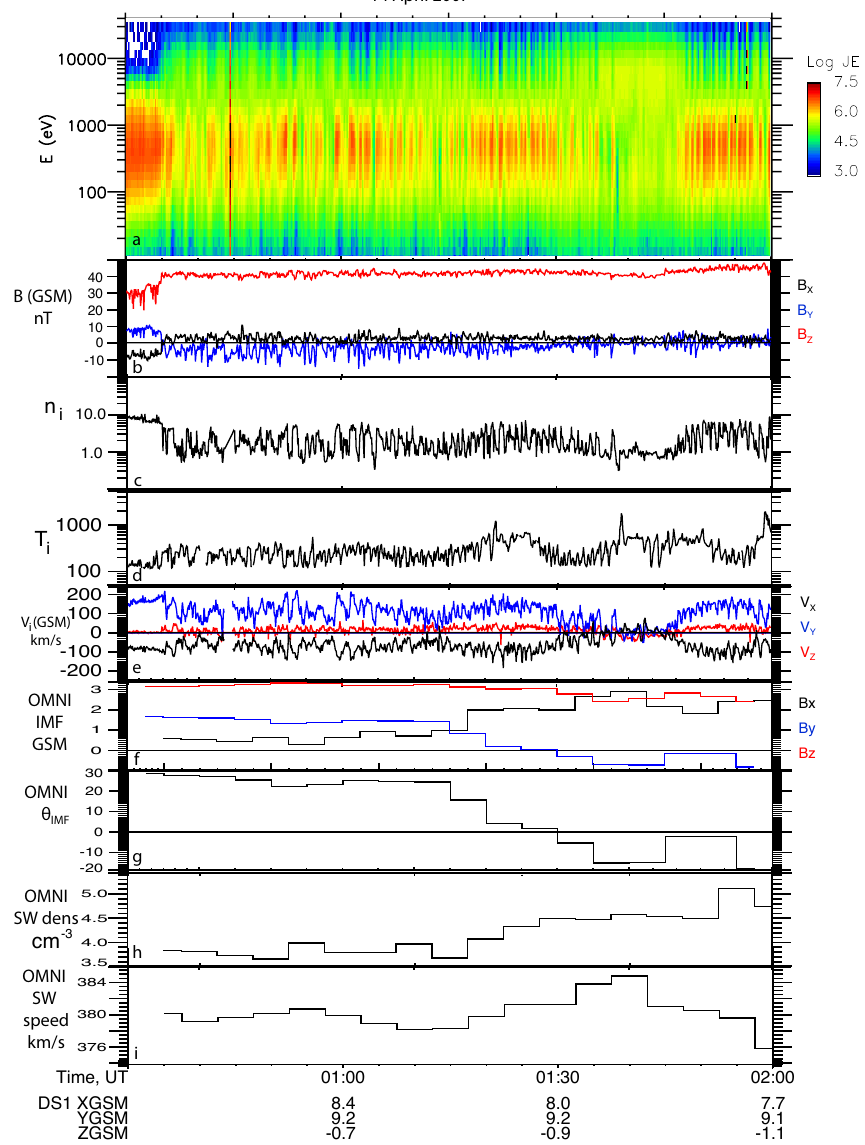
Fig. 1. An example magnetopause crossing on 14 April 2007. Panel (a) shows an omnidirectional ion differential energy flux spectrogram, panel (b) the magnetic field GSM components, panels (c) – (e) show the ion density, temperature (parallel and perpendicular components) and GSM velocity components. Panels (f) – (i) , show OMNI data, upstream solar wind conditions (where θ IMF =arctan( B y / B z ) GSM) time shifted to the magnetopause, by taking the OMNI parameters shifted to the Bow Shock (King and Papitashvili, 2005) and adding an extra 10min as described in the